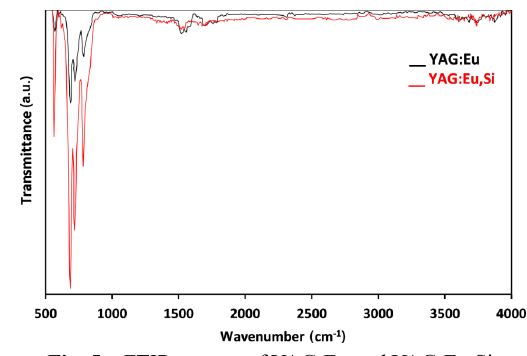
Fig. 5 FTIR spectra of YAG:Eu and YAG:Eu,Si.